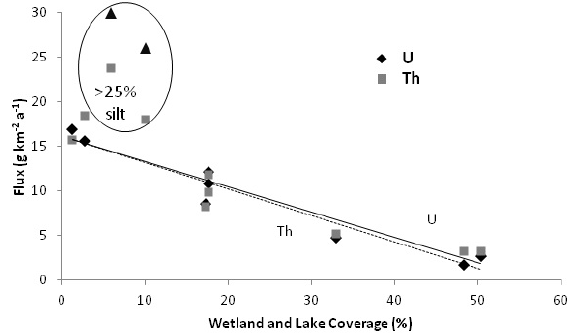
Fig. 4. Fluxes of uranium and thorium as a function of the wetland and lake coverage. The regression lines are based only on the catch- ments with less than 6% silt. The excluded catchments (C14 and C16) contain more than 25% silt – see details in the